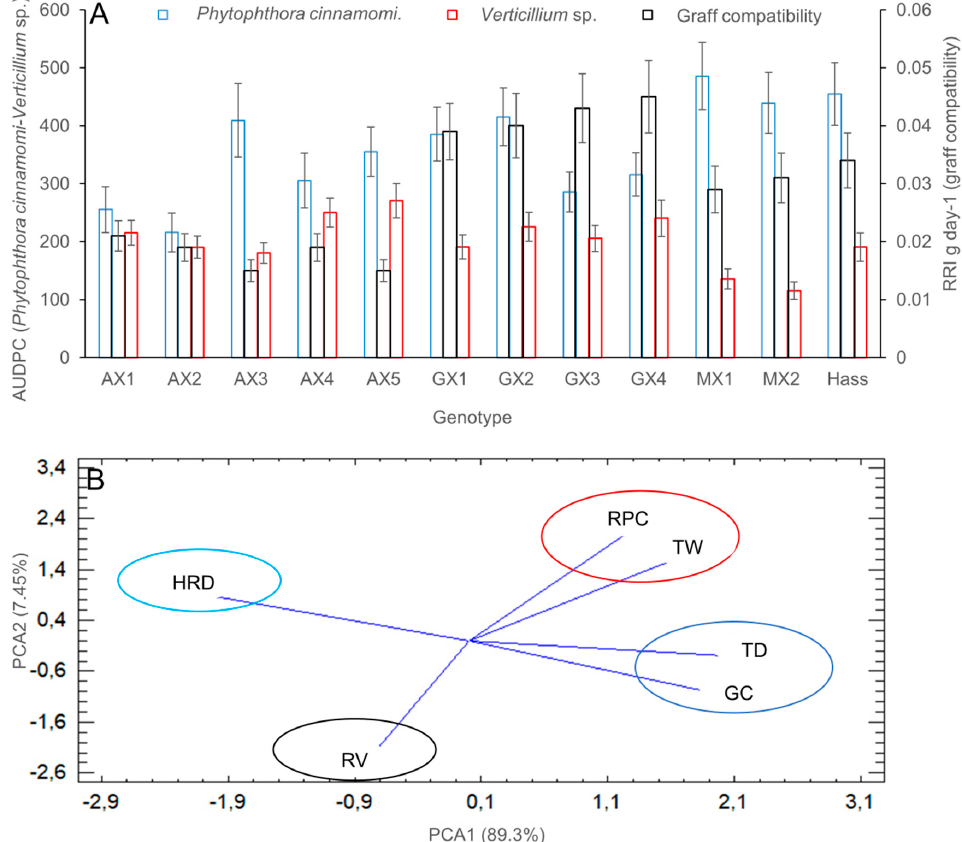
Figure 1. Tolerance of native rootstocks of P. americana to P. cinnamomi and Verticillium sp., and graft compatibility with cv. Hass. ( A ) AXN, morphotype of Persea americana var. americana (West Indian-type race); GXN, morphotype of Persea americana var. guatemalensis (Guatemalan-type race); MXN, morphotype of Persea americana var. drymifolia (Mexican-type race); RRI, relative rate increase (g day − 1 ); AUDPC, area under disease progress curve; error bars represent the confidence intervals of the mean, validated by the Tukey mean separation test and no overlapping of the error bars indicates significant di ff erences ( p < 0.05); ( B ) Clustering of genotypes based on evaluated agronomic variables. RPC, resistance to P. cinnamomic ; TW, tolerance to waterlogging; HRD, high rate of developed under extreme soil moisture; TD, tolerance to drought; GC, graft compatibility with cv. Hass genotype; RV, resistance to Verticillium